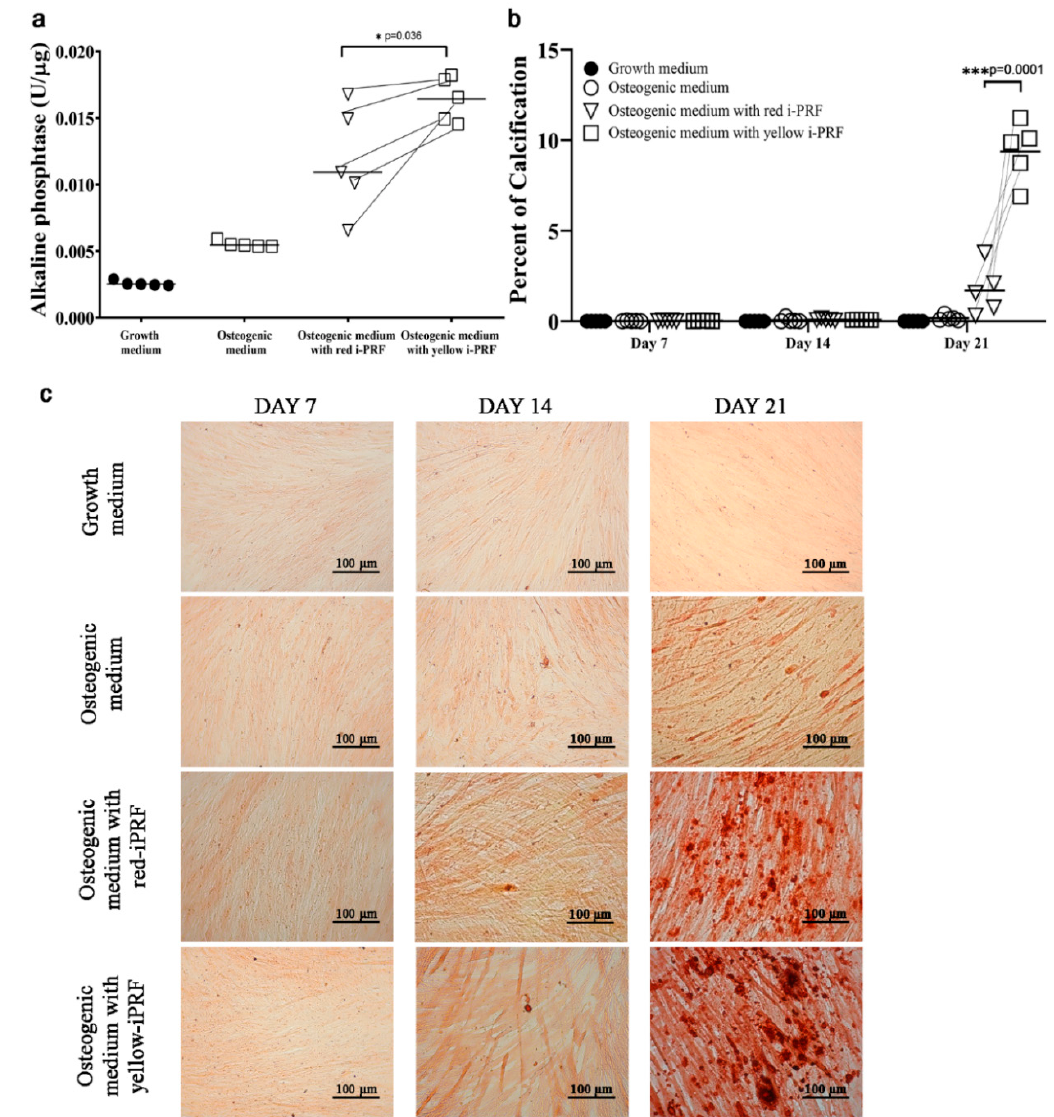
Figure 4. Osteogenic differentiation of periodontal ligament stem cells. Effects of the release from the i-PRF types on osteogenic differentiation were tested in parallel with osteogenic medium as the positive control and growth medium as the negative control. The release from the yellow i-PRF improved osteogenic differentiation more than the release from the red i-PRF demonstrated a significantly higher ( a ) alkaline phosphatase activity, ( b ) percent of calcification and ( c ) alizarin red staining (scale bar = 100µm). Significance was assessed using one-way ANOVA followed by post hoc least-significant difference tests to compare the differences between groups. The data are shown as individual donor pairs. * p<0.05 and *** p<0.001.